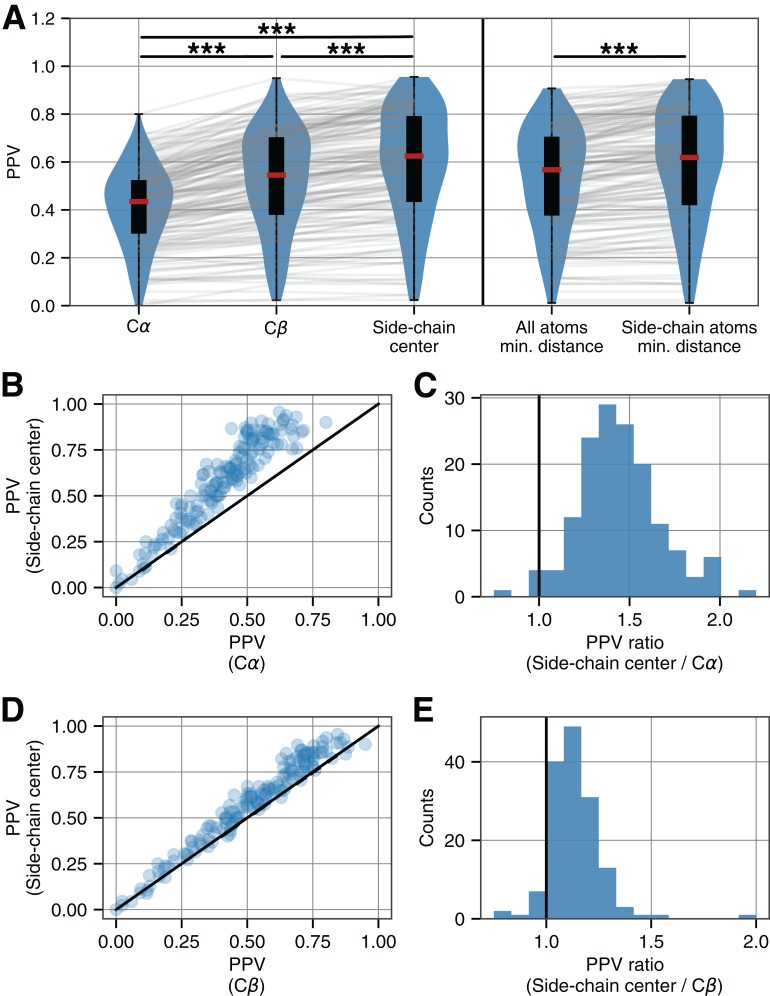
Accuracy of evolutionary couplings derived from empirical alignments.(A) For a diverse set of 150 proteins, the PPV of the top L/2 evolutionary coupling scores—derived from empirical sequence alignments—is progressively higher when intramolecular contacts are defined according to Cα atoms, Cβ atoms, and side-chain centers. Similarly, PPVs are higher when computing contacts based on side-chain atoms only as opposed to considering all possible interactions between atoms in residues (***indicates p < 10−20, Wilcoxon signed-rank test). (B) Scatter plot of PPVs for each protein according to Cα and side-chain center contact identification methods. (C) Histogram of the ratios from the data in (B) indicate that the median percent increase in accuracy is 43%. (D) and (E) As in (B) and (C), but now comparing Cβ and side-chain center contact identification methods. Results show a median percent increase in contact identification accuracy of 13% (Results for two other evolutionary coupling algorithm implementations can be found in Figs. S5 and S6. Further analyses performed with fixed distance cutoffs can be found in Figs. S7 and S8).